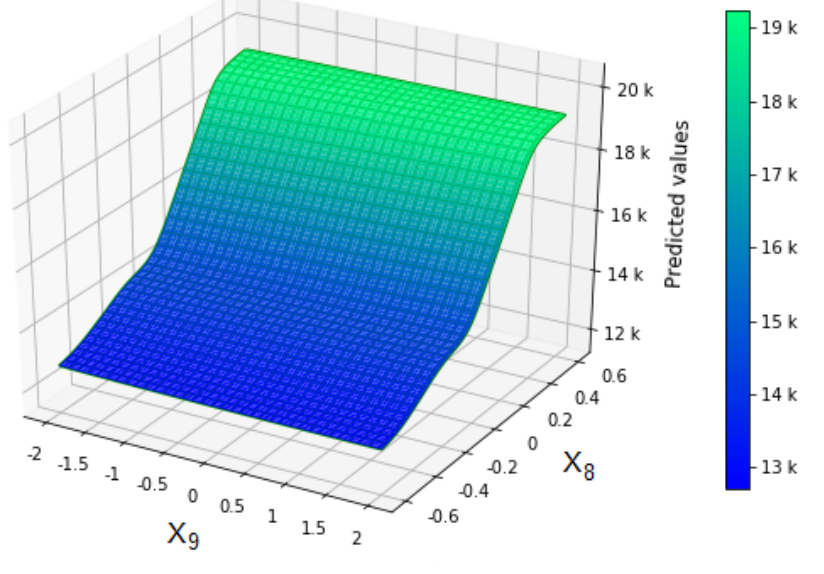
Figure A6. Two-dimensional curve of the ensemble of 10 best performing neural networks with respect to X 8 and X 9